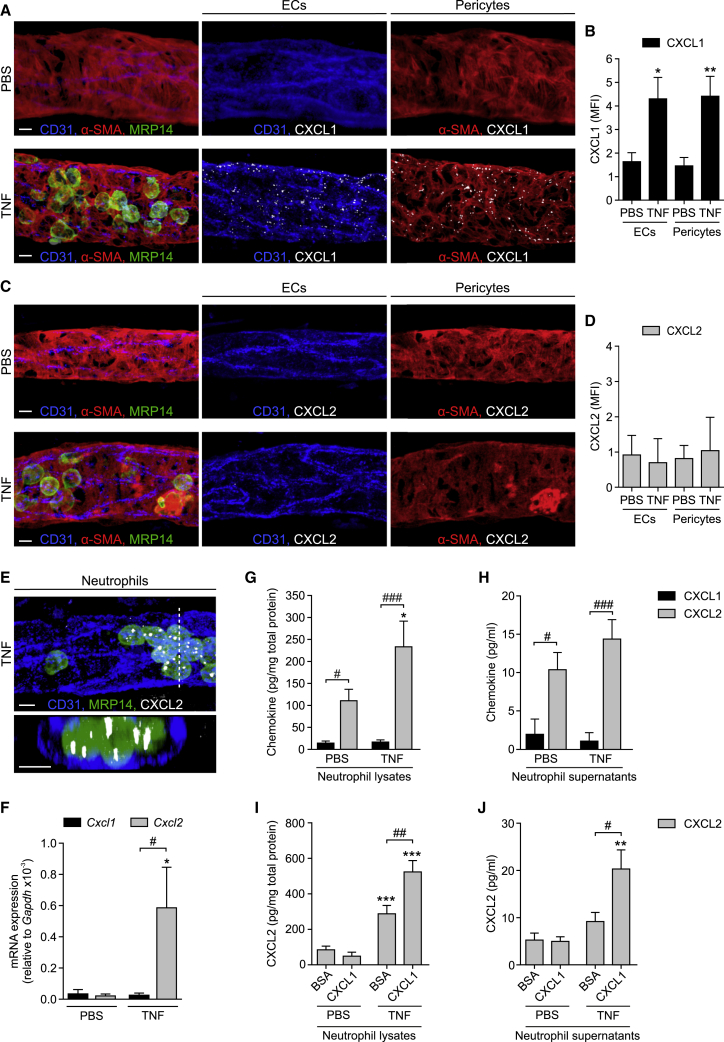
CXCL1 and CXCL2 Are Differentially Expressed in TNF-Stimulated Tissues(A–E) WT mice were treated i.s. with PBS or TNF and cremaster muscles were IF stained for CXCL1 or CXCL2 and CD31 (ECs), α-SMA (pericytes), and MRP14 (neutrophils). Representative confocal images of venules showing CXCL1 (A) or CXCL2 (C) staining within EC and pericyte isosurface masks and quantifications of CXCL1 (B) and CXCL2 (D) in ECs or pericytes, in terms of MFIs (n = 4 mice per group) from 4 independent experiments. (E) Confocal abluminal and cross-sectional images (acquired along the dashed line and presented at 90° rotation) of a venule showing overall CXCL2 staining representative of 4 independent experiments.(F) Cxcl1 and Cxcl2 mRNA levels relative to Gapdh in circulating neutrophils 2–3 hr after i.s. PBS or TNF injection as determined by real-time PCR (n = 4–5 mice per group, 2 independent experiments).(G–J) Purified mouse bone marrow neutrophils were treated with PBS or TNF (1 nM, 1 hr) on uncoated (G, H), BSA-coated, or CXCL1-coated wells (I, J). CXCL1 and/or CXCL2 levels in lysates (G and I) and supernatants (H and J) as quantified by ELISA (n = 4–12) from 2–4 independent experiments. Means ± SEM, ∗p < 0.05, ∗∗p < 0.01, ∗∗∗p < 0.001 as compared to corresponding PBS-treated ctrls and #p < 0.05, ##p < 0.01, ###p < 0.001, as indicated. Scale bars, 5 μm.See also Figure S4.